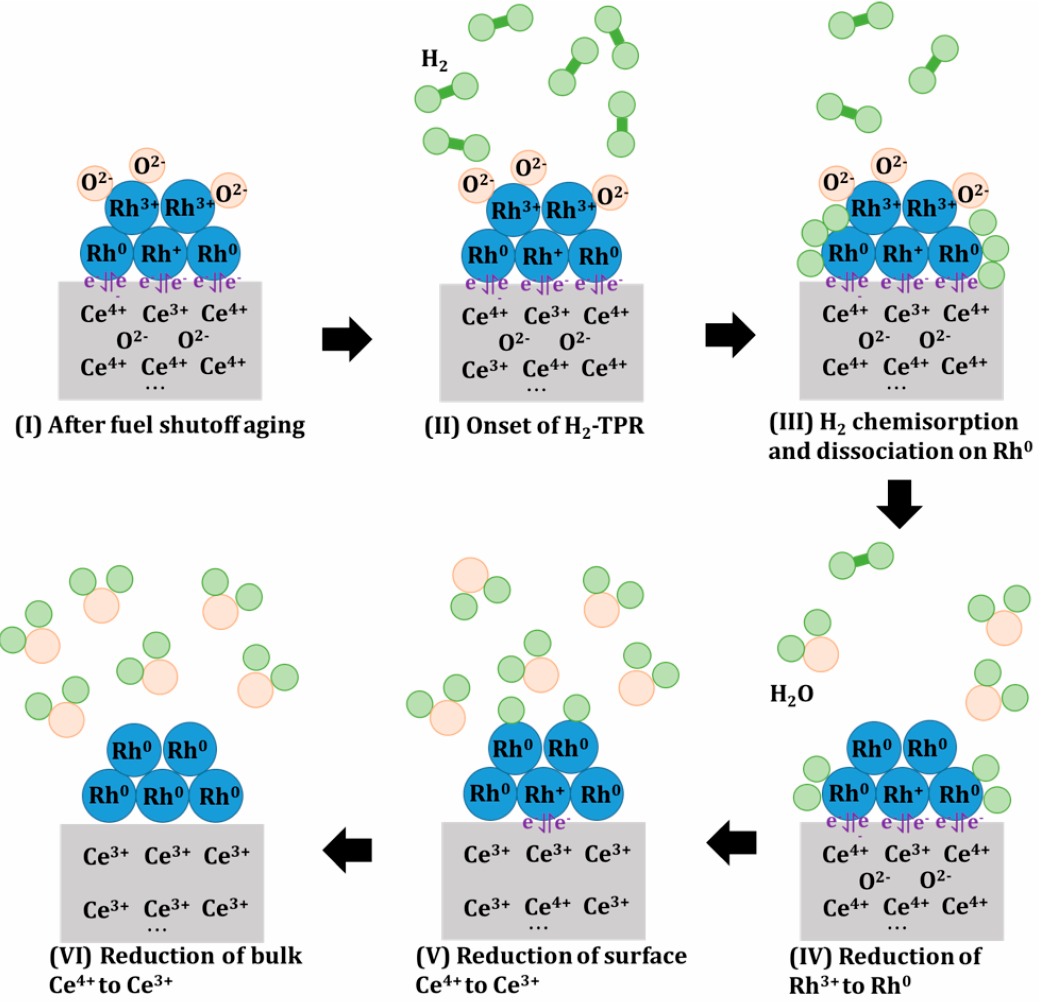
Figure 12. Speculative schematic of proposed redox reaction mechanism and interaction between Rh δ+ /Rh 0 and Ce 4+ /Ce 3+ redox couple during H 2 -TPR of 0.5% Rh/CZO. The redox reactions followed the order described below. ( I ) After simulated fuel shutoff aging in air at 800 °C, 950 °C, or 1050 °C, surface Rh sites are oxidized to Rh 2 O 3 , while the Rh sites in close contacts with Ce x O y remained in reduced states (Rh δ+ , 0 < δ < 1), with Rh δ+ /Rh 0 and Ce 4+ /Ce 3+ redox couple formed for enhancing electron transfer efficiency; ( II ) H 2 flow through the sample; ( III ) At low temperature regime around 100 °C to 120 °C, H 2 was chemisorbed and dissociated on the Rh 0 sites, followed by ( IV ) Reduction of Rh 3+ to Rh 0 ; ( V ) Reduction of surface Ce 4+ sites to Ce 3+ promoted by the Rh δ+ /Rh 0 and Ce 4+ /Ce 3+ redox couple; ( VI ) Reduction of bulk Ce 4+ sites to Ce 3+ when more H 2 molecules were chemisorbed and dissociated on Rh 0